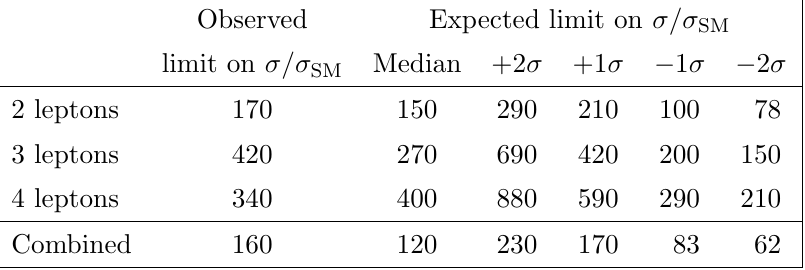
Table 2 . Expected and observed 95% CL exclusion limits set on the non-resonant HH signal p strength. The SM non-resonant HH cross-section at s = 13 TeV is calculated to be 33.4 fb. Limits are shown for each channel individually as well as for the combination of the channels. Statistical and systematic uncertainties are included.